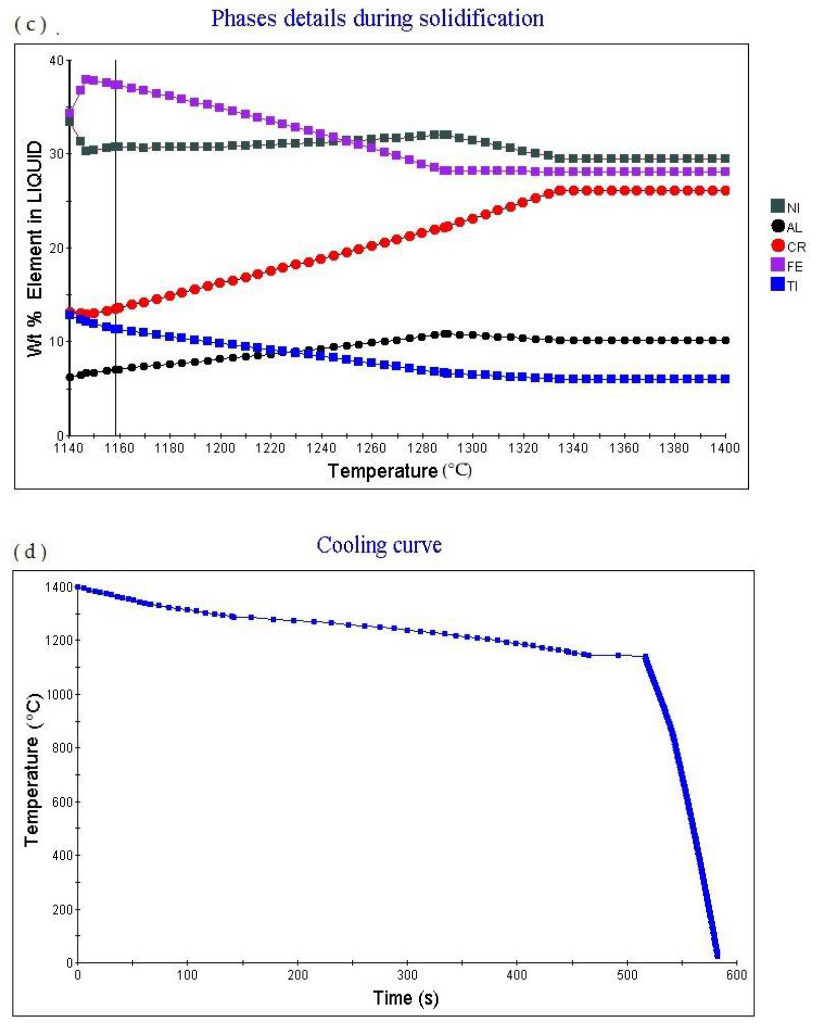
Figure 3. Solidification physical properties for Fe 25 Cr 25 Ni 25 Ti 6.25 Al 18.75 multi-principle element alloys. ( a ) general physical properties (fraction solid–temperature); ( b ) general physical properties (fraction liquid–temperature); ( c ) wt.% element in liquid–temperature; ( d ) cooling curve (tempera- ture–time).